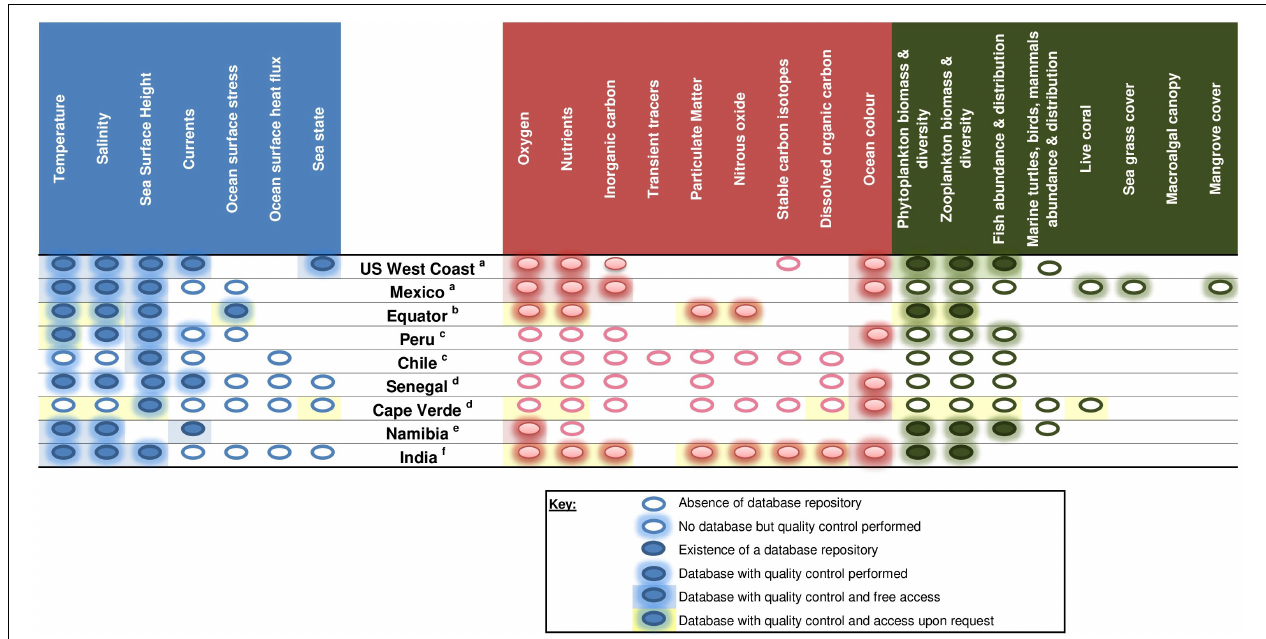
FIGURE 11 | Current status of data management and information product delivery with respect to essential ocean variables (EOVs) in the oxygen minimum zone (OMZ) regions participating in the readiness level assessment.